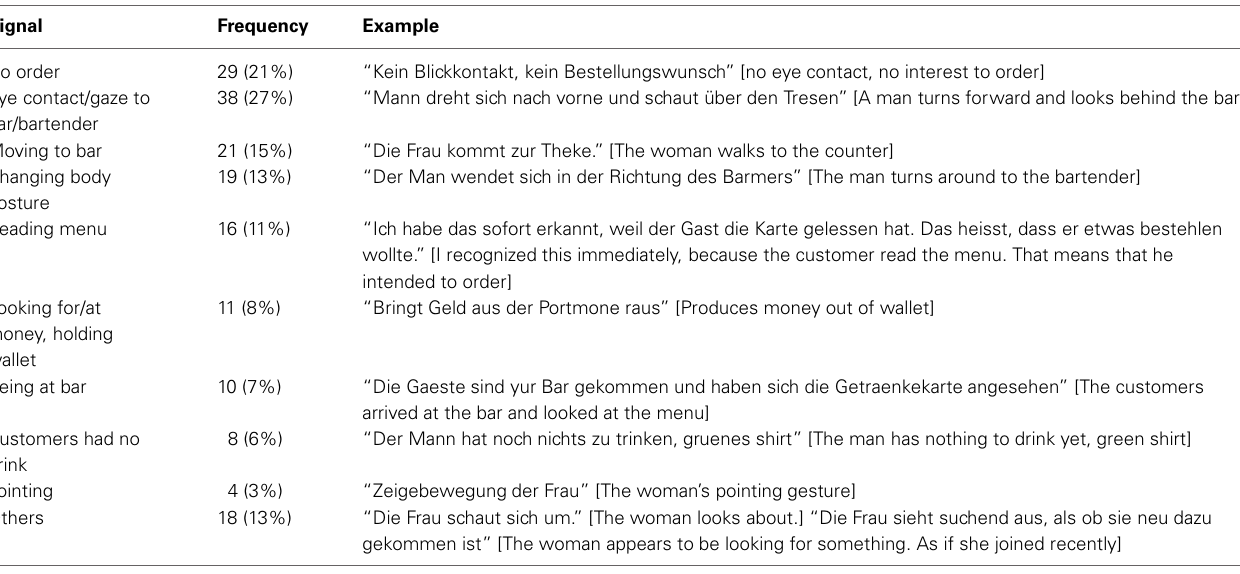
Table 6 | Frequency of the signals mentioned in the interview